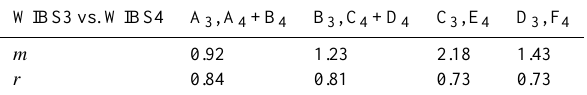
Table 6. Gradient, m , of straight line least squares regression fit through zero of scattered data, and Pearson’s r , for cluster time se- ries from each WIBS instrument. Only profile data from below 5m were used to aid comparison.